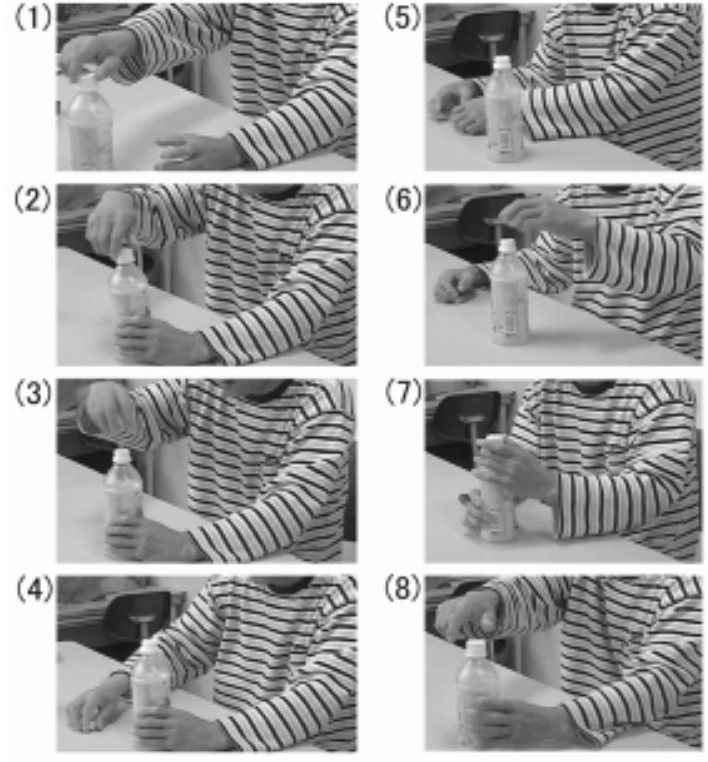
Fig. 3. An example of the diagonistic dyspraxia observed in this case. The numbers in parentheses indicate the temporal order of the patient’s reactions when he was asked to open the cap of a plastic bottle. (1) His right hand grasped the bottle at the cap and brought it to him. (2) & (3) His right hand opened the cap. While his right hand was performing this action, his left hand helped his right hand by holding the bottle. (4) His right hand placed the cap on the table. (5) As soon as the cap was placed on the table, his left hand picked it up. (6) His left hand moved the cap back on to the bottle. (7) The left hand capped the bottle. While his left hand was performing this antagonistic action, his right hand helped his left hand by holding the bottle. (8) While his left hand pushed the bottle toward us, his right hand followed it to catch the bottle at the cap. Then the right hand opened the cap again, with the left hand holding the bottle. Opening by the right hand and capping by the left hand with the other hand holding the bottle were repeated until he was